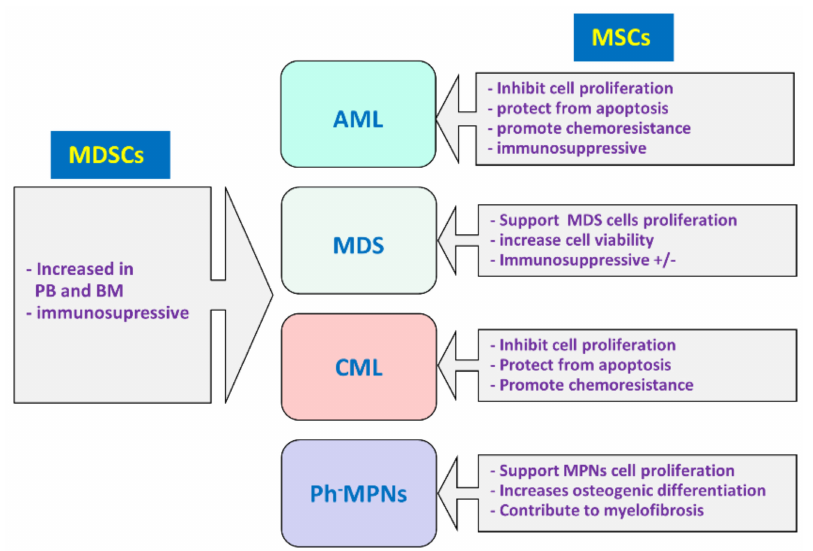
Figure 2. Main features of MDSCs and MSCs in myeloid malignancies. The number of MDSCs is elevated in peripheral blood (PB) and bone marrow (BM) of patients with myeloid malignancies, and they exhibit potent immunosuppressive functions. MSCs mainly support neoplastic myeloid cells and may promote chemoresistance; depending on the myeloid malignancy subtype, they may exert specific functions, as indicated in the figure. AML, acute myeloid leukemia; MDS, myelodys- plastic syndrome; CML, chronic myeloid leukemia; Ph-MPN, Philadelphia chromosome-negative myeloproliferative